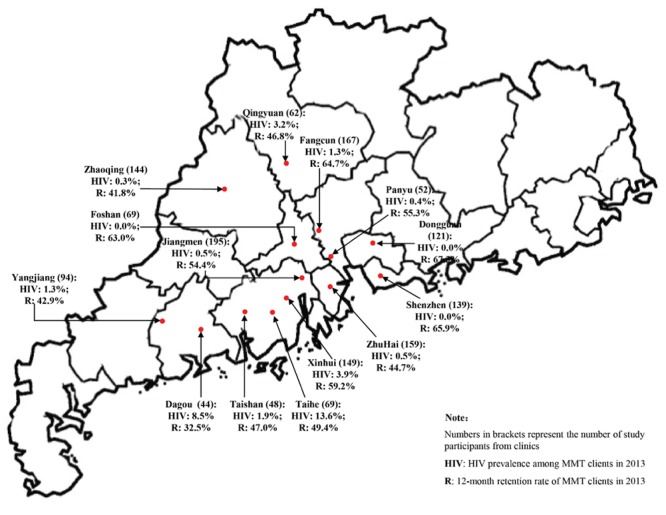
Geographical location, HIV prevalence and 12-month retention rates of study participants in 14 MMT clinics in Guangdong province in 2013.